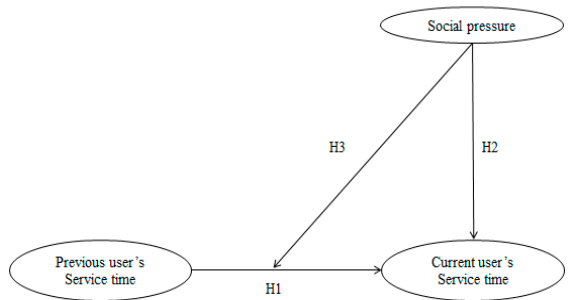
Figure 1. Hypotheses. Figure 1.